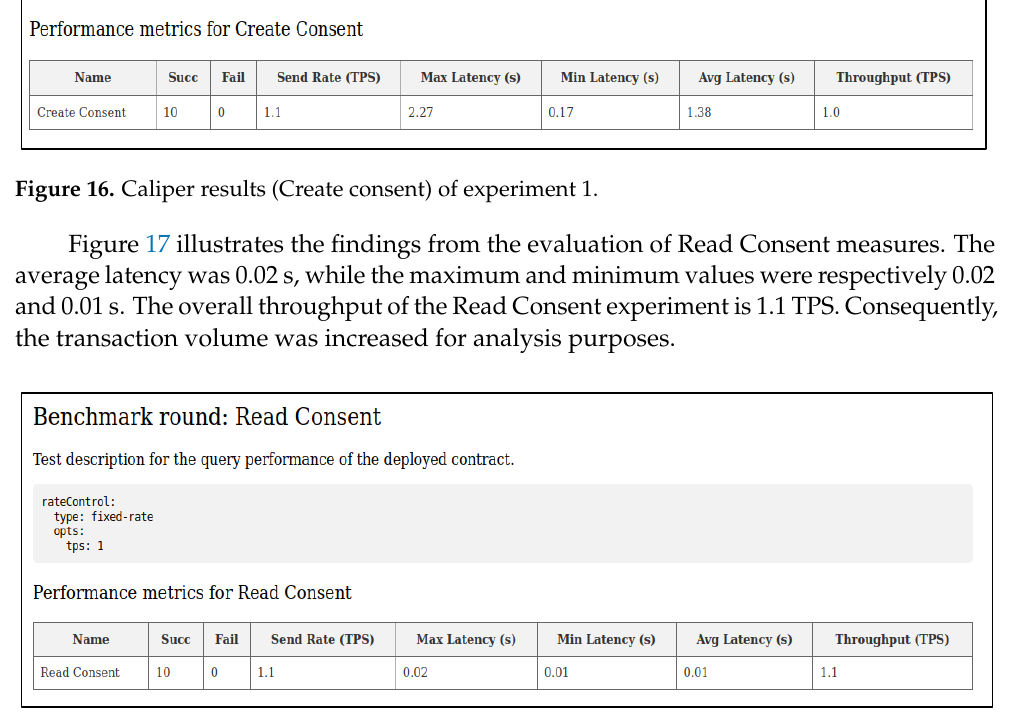
Figure 17. Caliper results (Read Consent) of experiment 1.